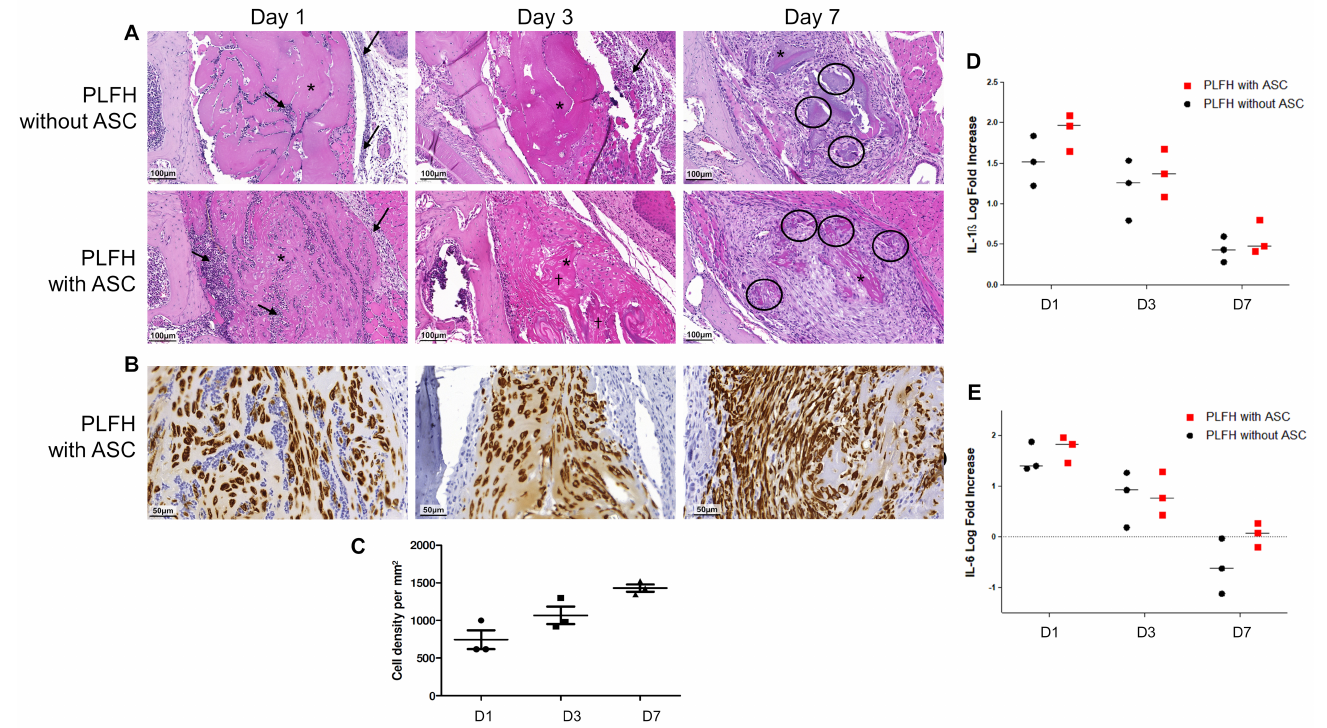
Figure 6. PLFH biodegradation, local tolerance and ASC fate after subgingival administration of miniaturized implant. ( A ) PLFH (*) biodegradation without (upper panel) or with ASC (middle panel) 1, 3, 7 days after surgical implantation. Day 1, neutrophilic infiltration (arrows) with a slight serous exudation around the PLFH (empty spaces). Day 3, PLFH fragmentation, resorption and shrinkage, areas of ASC death (†), peripheral mononuclear cell (mainly macrophages). Day 7, multifocal calcium precipitations with granulomatous foreign body reaction (circles) and significant PLFH resorption/biodegradation. ( B ) Vimentin immunostaining demonstrated the great ASC number, density, and viability. ( C ) Cell density doubled between day 1 and 7. (D-E) IL1- β ( D ) and IL6 ( E ) expression in subgingival tissue after PLFH with or without ASC implantation. Three animals by timepoint and by group were